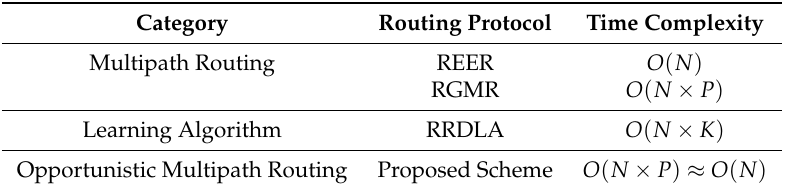
Table 2. Time complexity of the proposed scheme and other